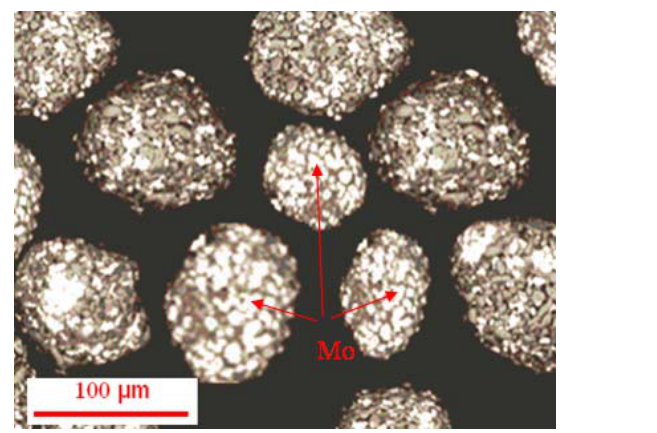
Figure 2 – (SEM) Scanning electron micrography of Ni5,5wt.%Al 5wt.% Mo powder